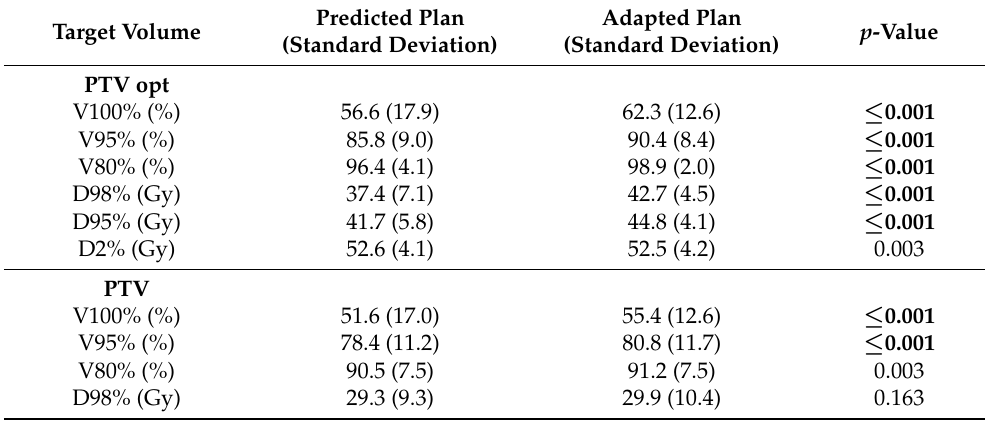
Table 3. Average target volume and OAR dosimetric results for predicted and adapted